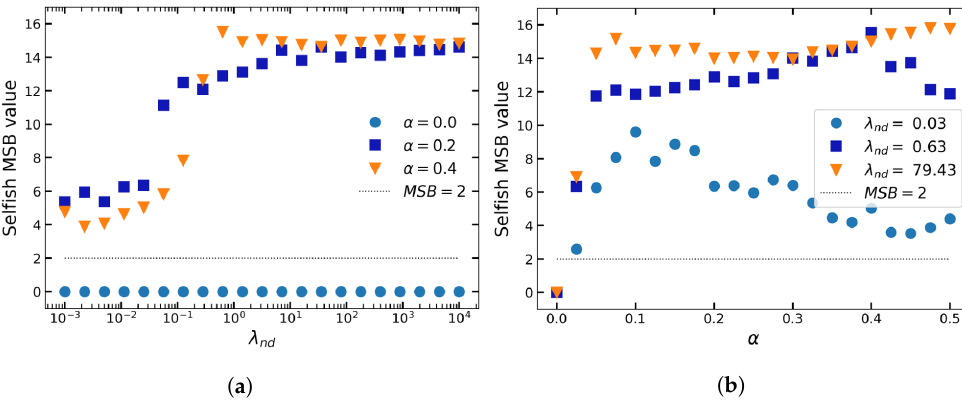
Figure 9. MSB index as a function of ( a ) latency ( λ nd ) and ( b ) selfish hashing power ( α